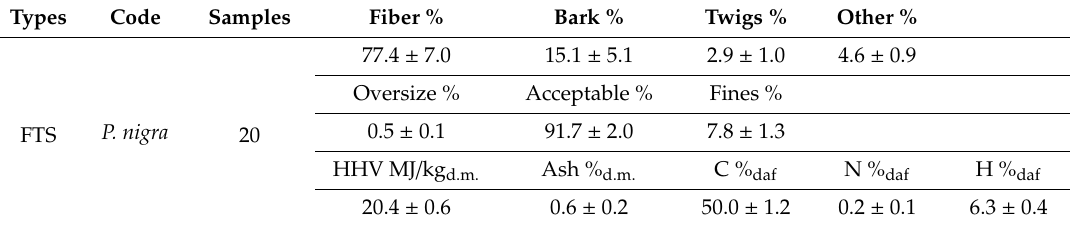
Table 11. Wood chips characterizations from Picchio et al. [43], average values ± standard deviation.